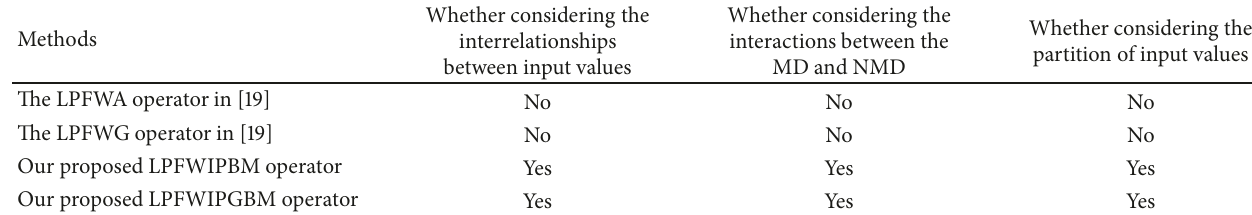
Table 11: The differences between our studies and existing studies for